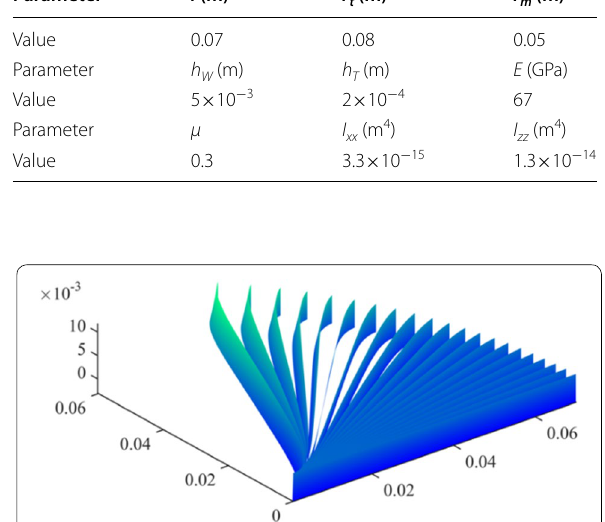
Figure 7 Deformations of the single leaf spring from 0 to 60